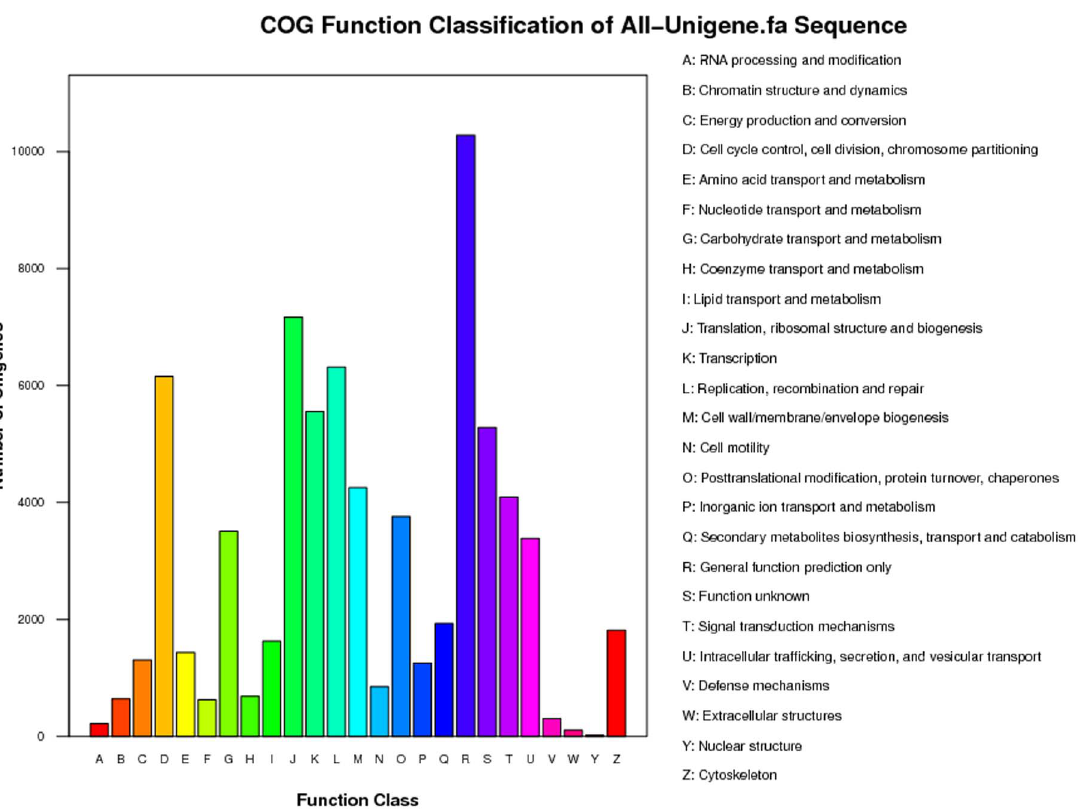
Figure 1. Histogram presentation of the results from the classification using the Clusters of Orthologous Groups (COG).